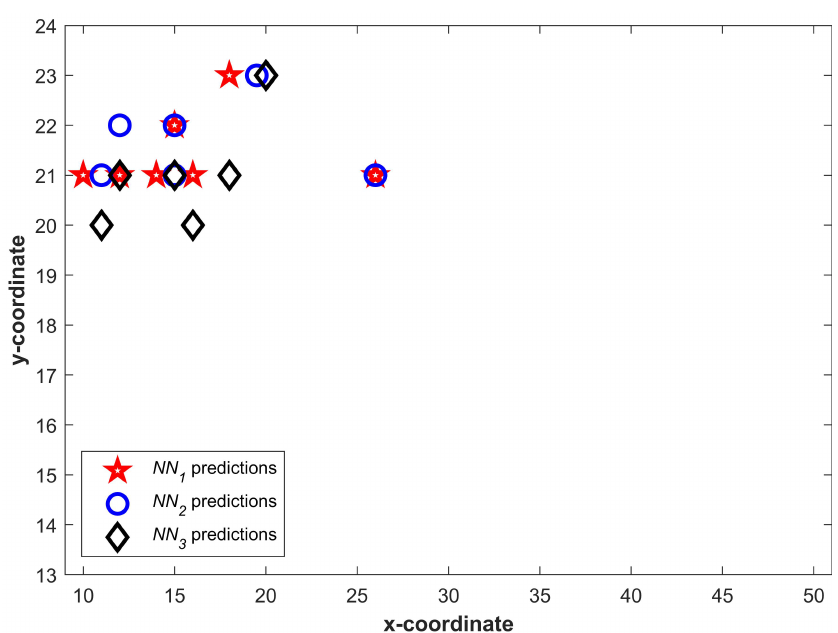
Figure 8. Selected predictions from neural networks after using Equation